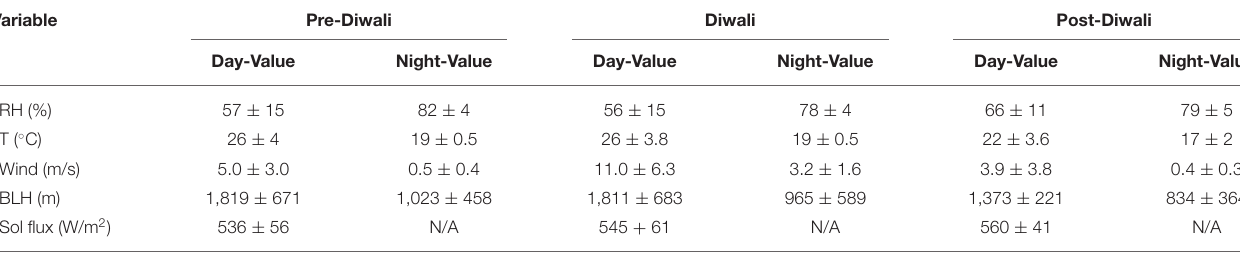
TABLE 2 | Summary of meteorological conditions (Avg. ± SD) during the period of measurements.